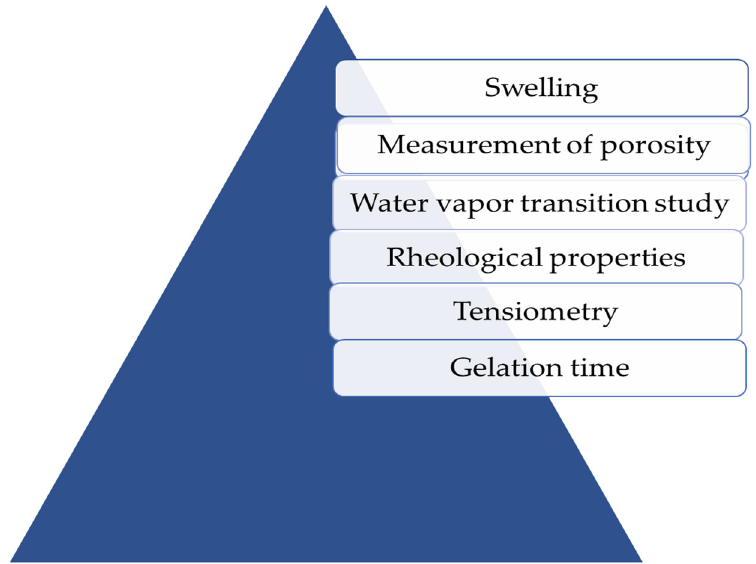
Figure 3 . Evaluation parameters of hydrogels. Figure 3. Evaluation parameters of